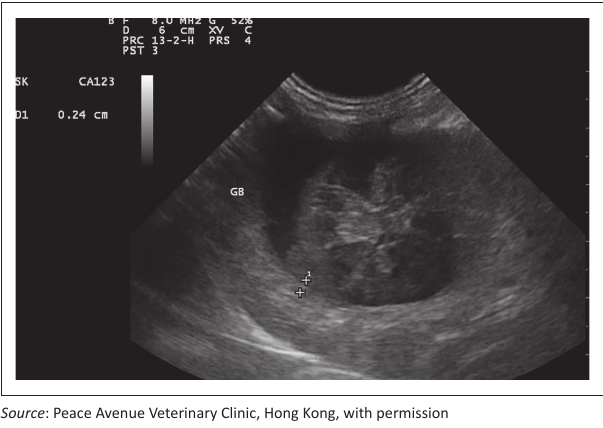
anechoic rim. The gallbladder wall is not visibly thickened. The mucocoele is not the typical kiwi-like to stellate pattern that typifies this disease but rather moth-eaten in appearance. FIGURE 1: Ultrasonographic image (8 MHz convex array probe, Esaote, MyLab, Genoa, Italy) of a sagittal section of a gallbladder in a dog diagnosed with a gallbladder